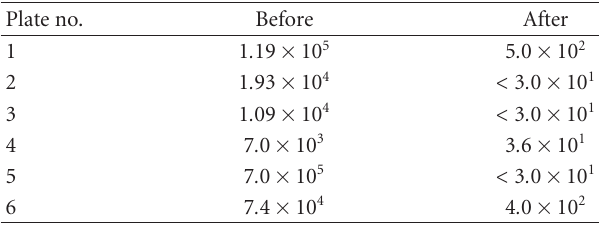
Table 2: Colony counts before insertion of povidone-iodine and after